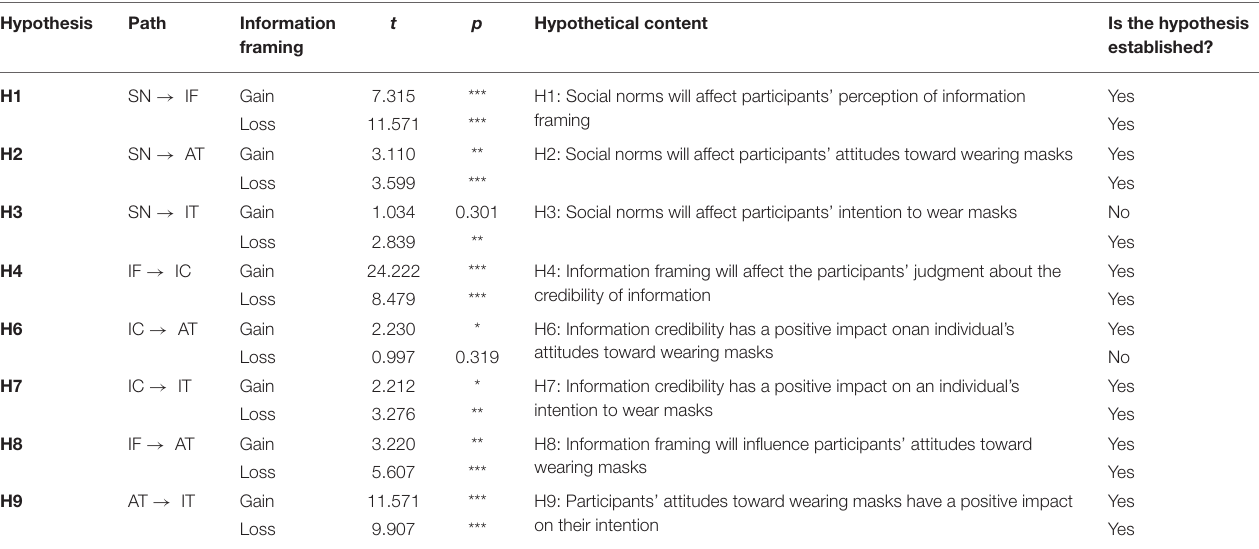
TABLE 3 | Support of model path hypothesis. Hypothesis